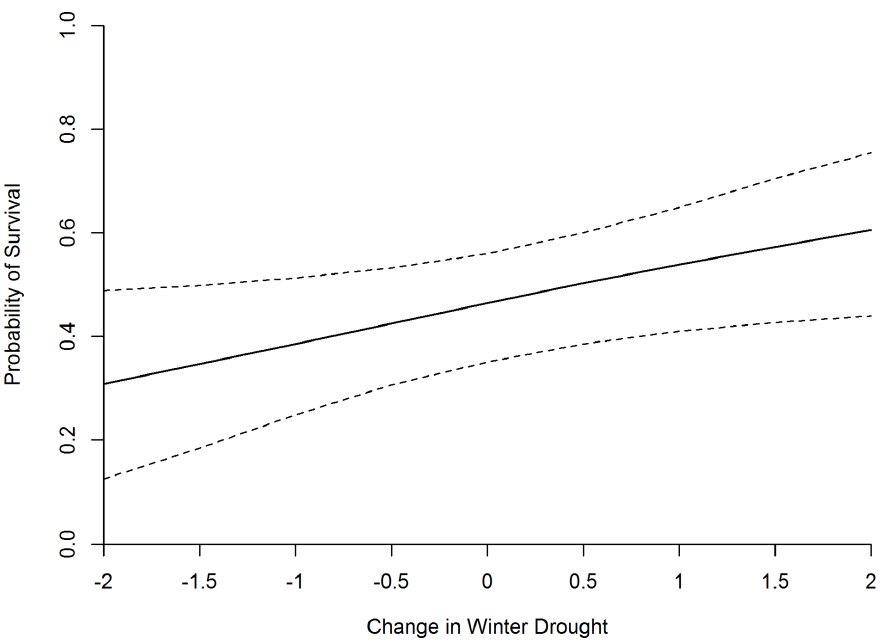
Figure 2. Effects of changes in winter drought severity (PZI) on the probability of greater sage-grouse chick survival to 42 days of age. Dashed lines indicate 95% confidence intervals. Negative values correspond to increasingly severe drought conditions. A change of 0.0 is equal to the mean Winter Palmer Z-Index score observed during the extent of this study. Palmer (1965) stated that a drought score of -2 was indicative of moderate drought. doi:10.1371/journal.pone.0065582.g002 day survival probability of 0.475 (95% CI = 0.375 to 0.566).